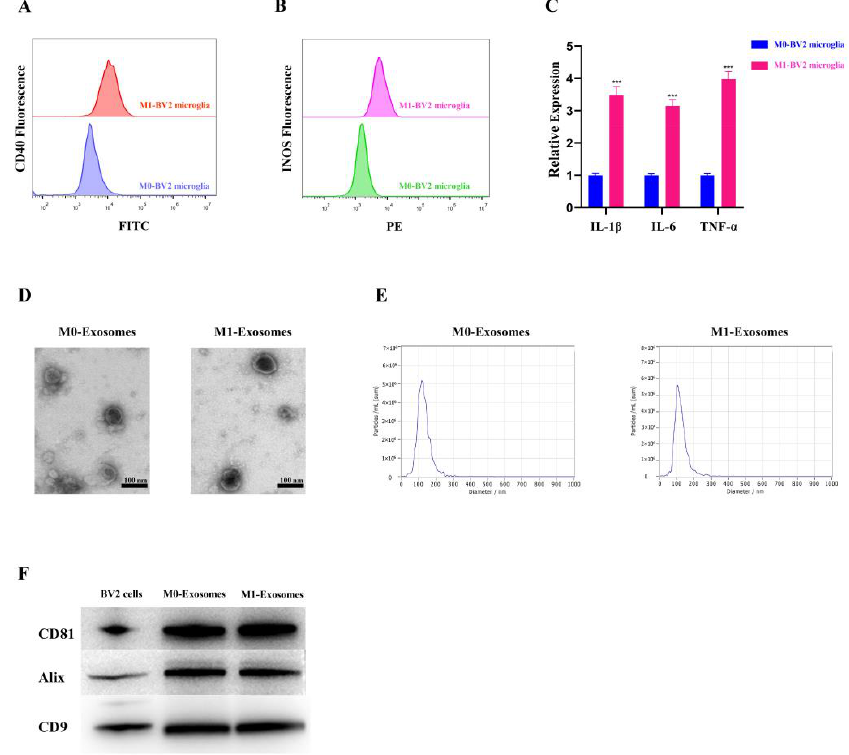
Figure 1. The characterization of polarized M1-BV2 microglia and exosomes. ( A , B ) Flow cytometry results showing expression of CD40 and INOS markers in BV2 microglia. ( C ) Relative expression of IL-1 β , IL-6, and TNF- α in BV2 microglia (*** p < 0.001). ( D ) Transmission electron microscopic images of extracted M0-BV2 and M1-BV2 exosomes. ( E ) Diameter of the extracted M0-BV2 and M1-BV2 exosomes. ( F ) Measurement of the exosome-specific proteins CD81, Alix, and CD9 by Western blot. Data are presented as the mean ± SD of three independent experiments.